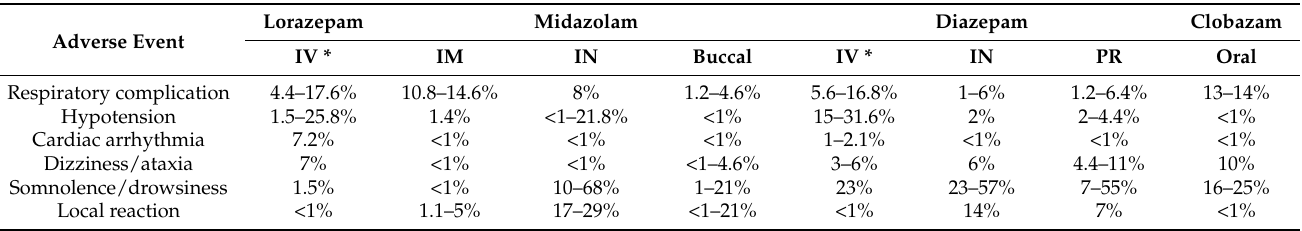
Table 6. Benzodiazepine adverse events associated with route of administration [12,16,18,20,22–26,29,30,66,68,76–78,85–94]. Adverse